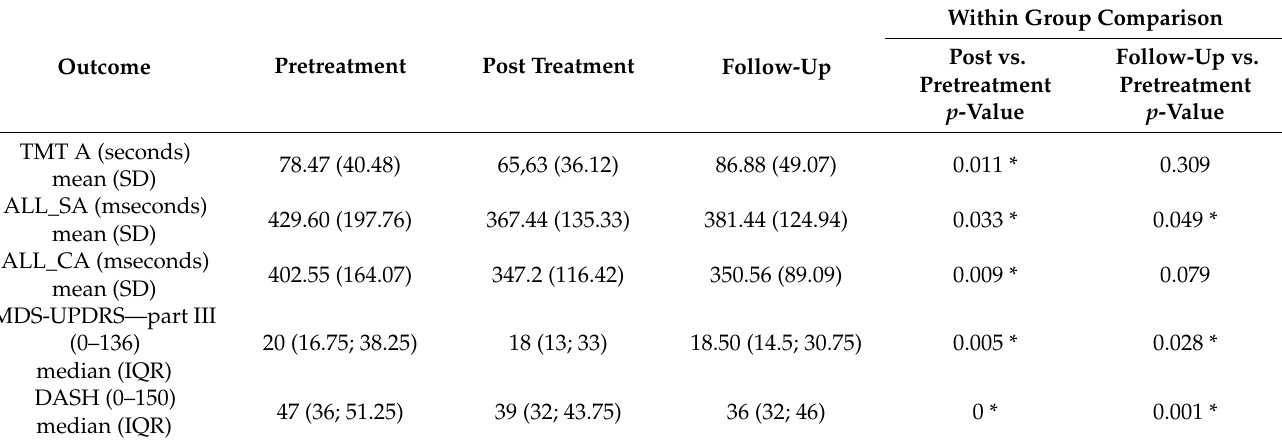
Table 1. Within-group comparisons for outcome measures analyzed using non-parametric